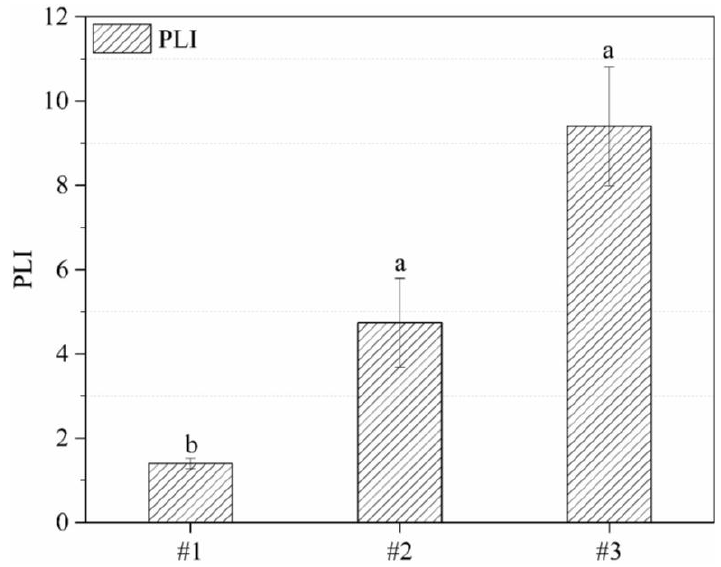
Figure 3. Difference of pollution load index (PLI ± SD) and statistical test ( p < 0.05) between three abandoned sites. Bars marked with same letter are not significantly different at p = 0.05.